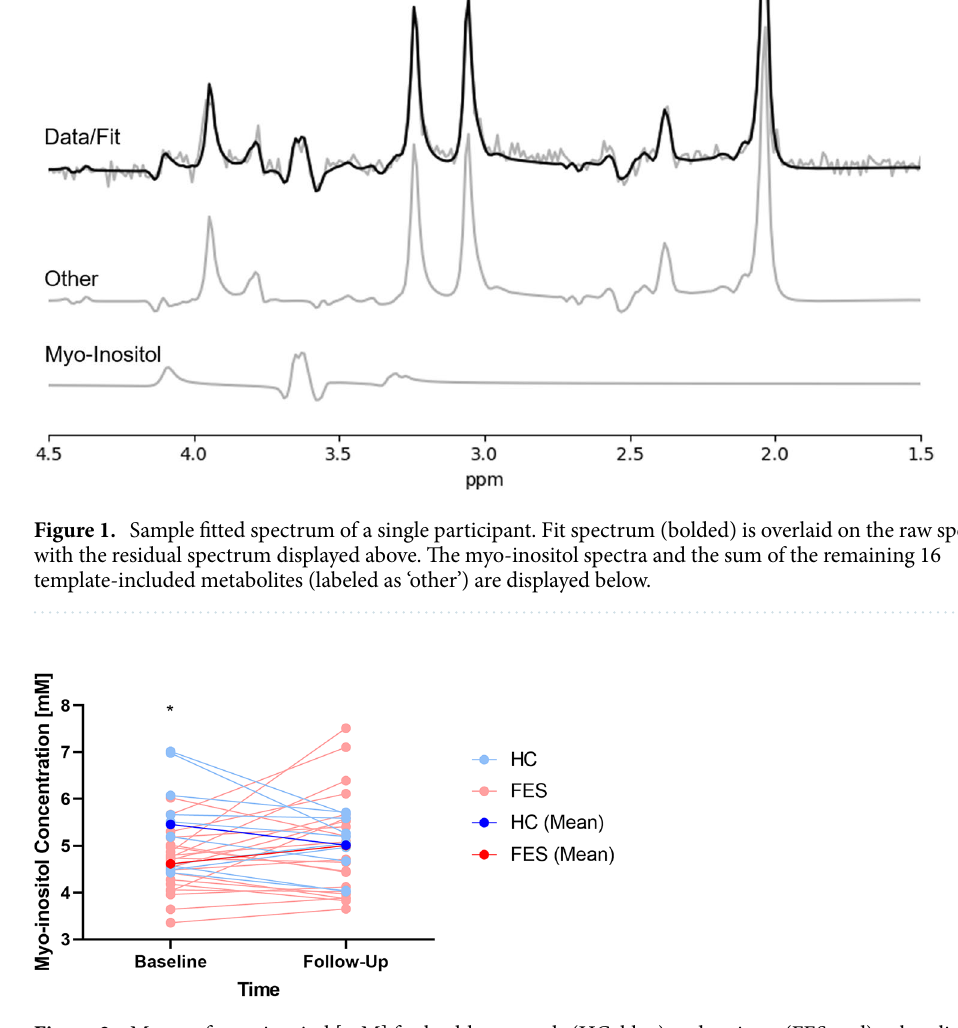
Figure 2. Means of myo-inositol [mM] for healthy controls (HC, blue) and patients (FES, red) at baseline and follow-up scan sessions. Subject-level myo-inositol changes are shown in light blue for healthy controls and pink for patients. Asterisk denotes significant difference between means (Note: y-axis values do not begin at 0 for improving data